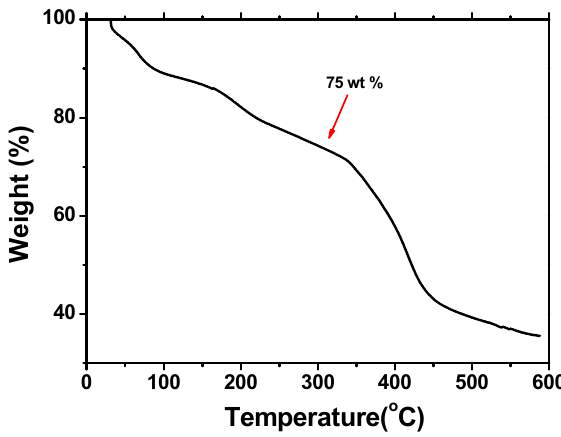
Figure 4. TG curve of polymer PTEBS heated from 0 to 600 °C.